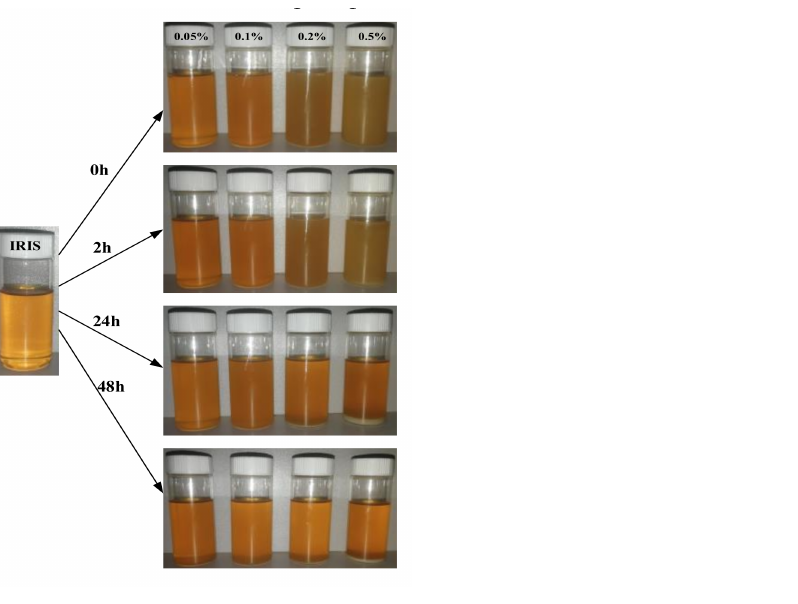
Figure 9. Dispersion stability of lanthanum stearate with different concentrations in IRIS with time. In order to further quantitatively analyze the dispersion stability of lanthanum stearate at low concentration, the absorbance values of the upper oil samples were measured.